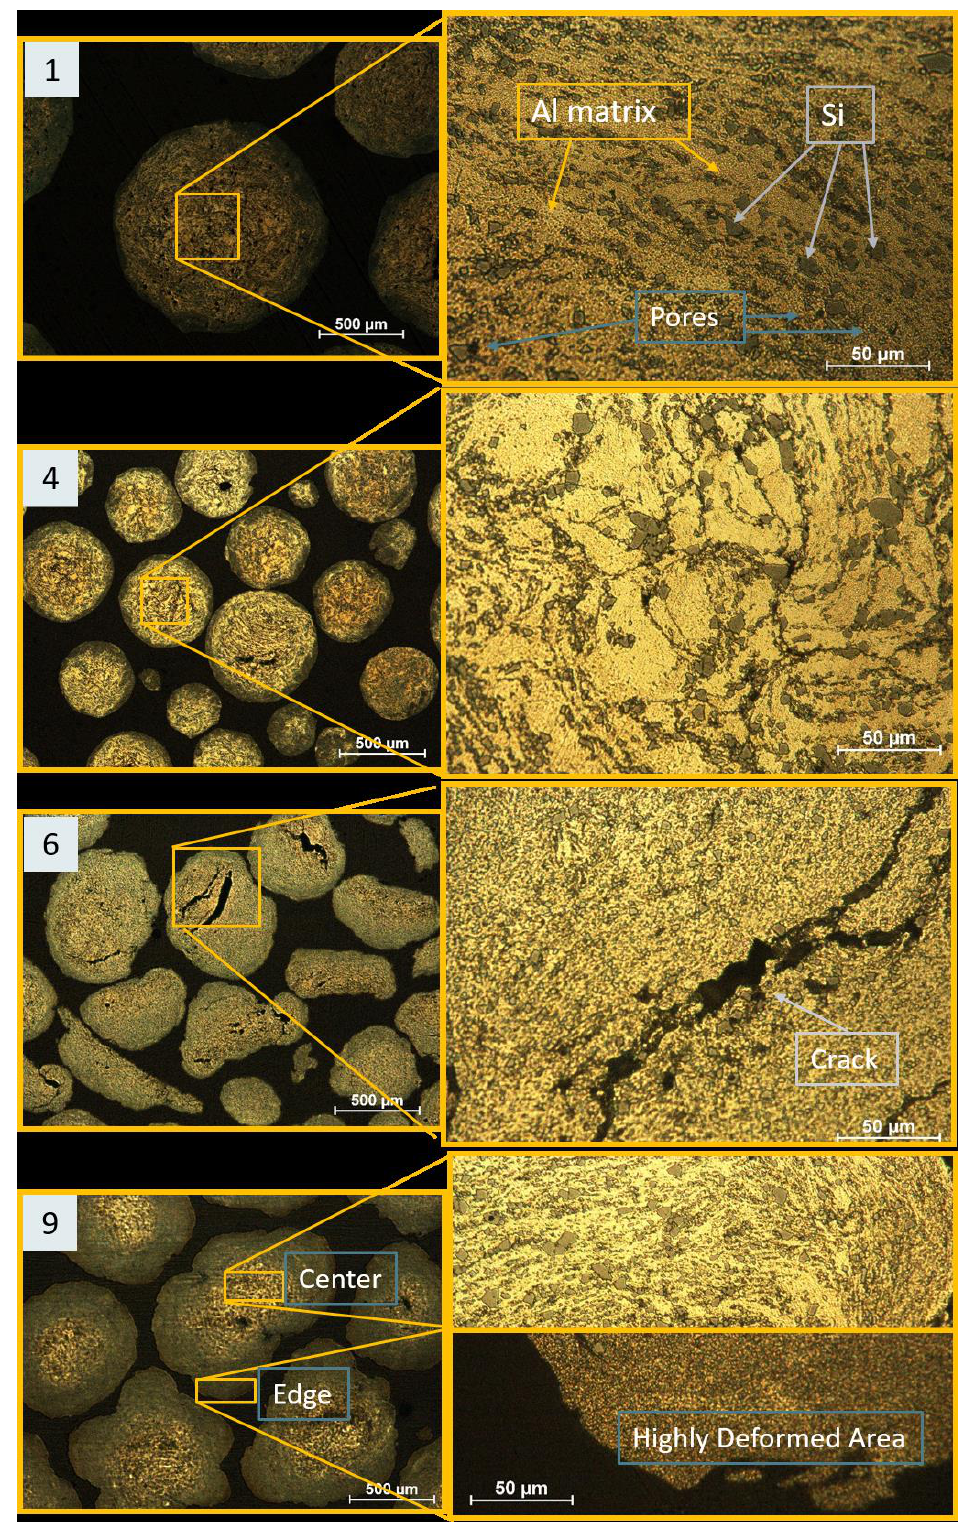
Figure 4. Optical microstructures of 1st, 4th, 6th, and 9th specimens from top to bottom, with 50× ( left ), and 500× ( right ) magnifications.